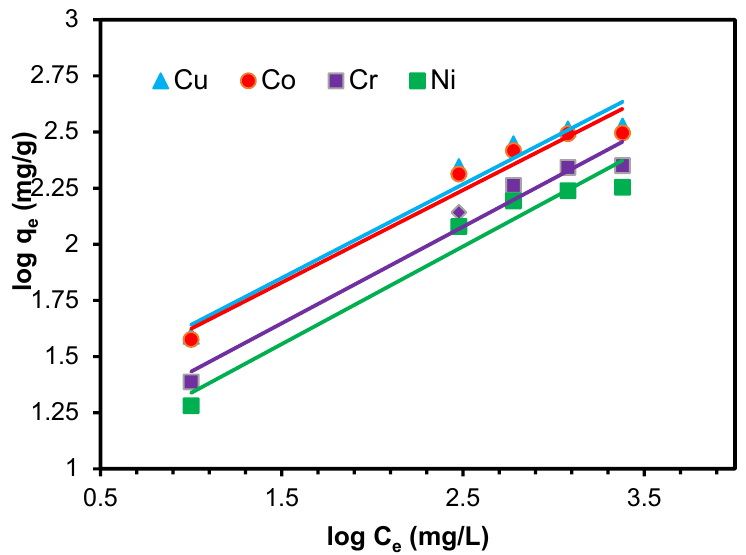
Figure 14. Linear plots of Freundlich adsorption isotherm by poly(hydroxamic acid) ligand; experimental conditions: 100 mg of poly(hydroxamic acid), 5 mL of 0.1 M CH 3 COONa buffer solution, and